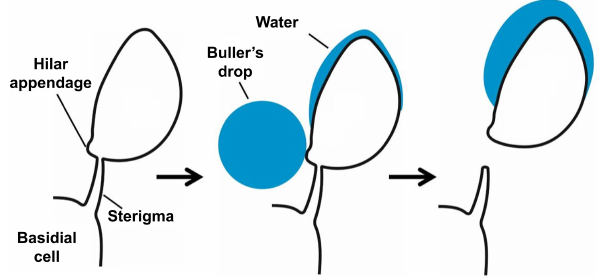
Figure 1. Schematic drawing of the spore-building parts of a basid- iomycetous fungus. Active release mechanism based on a change of the gravity center due to the “Buller’s drop” effect. Not to scale. Based on Piepenbring